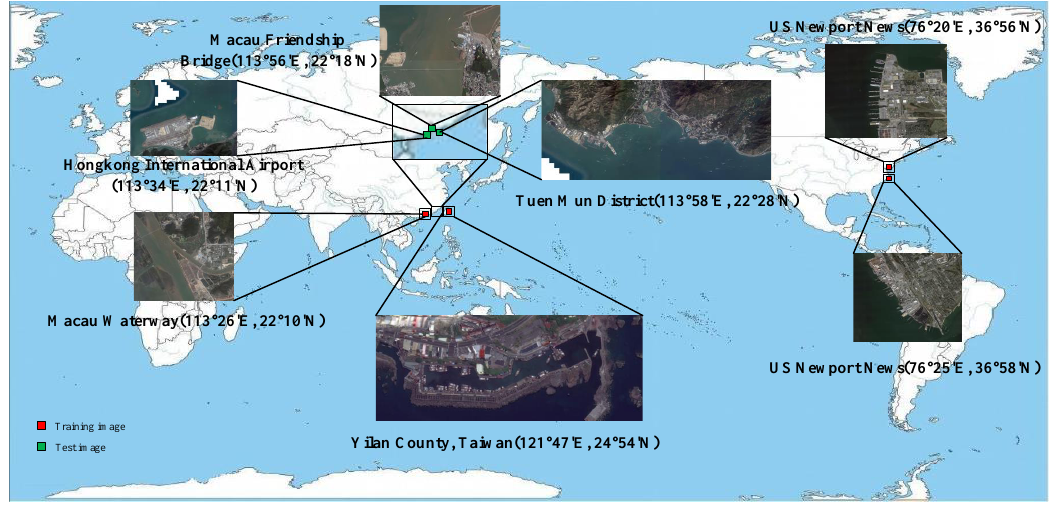
Figure 10. The data set we